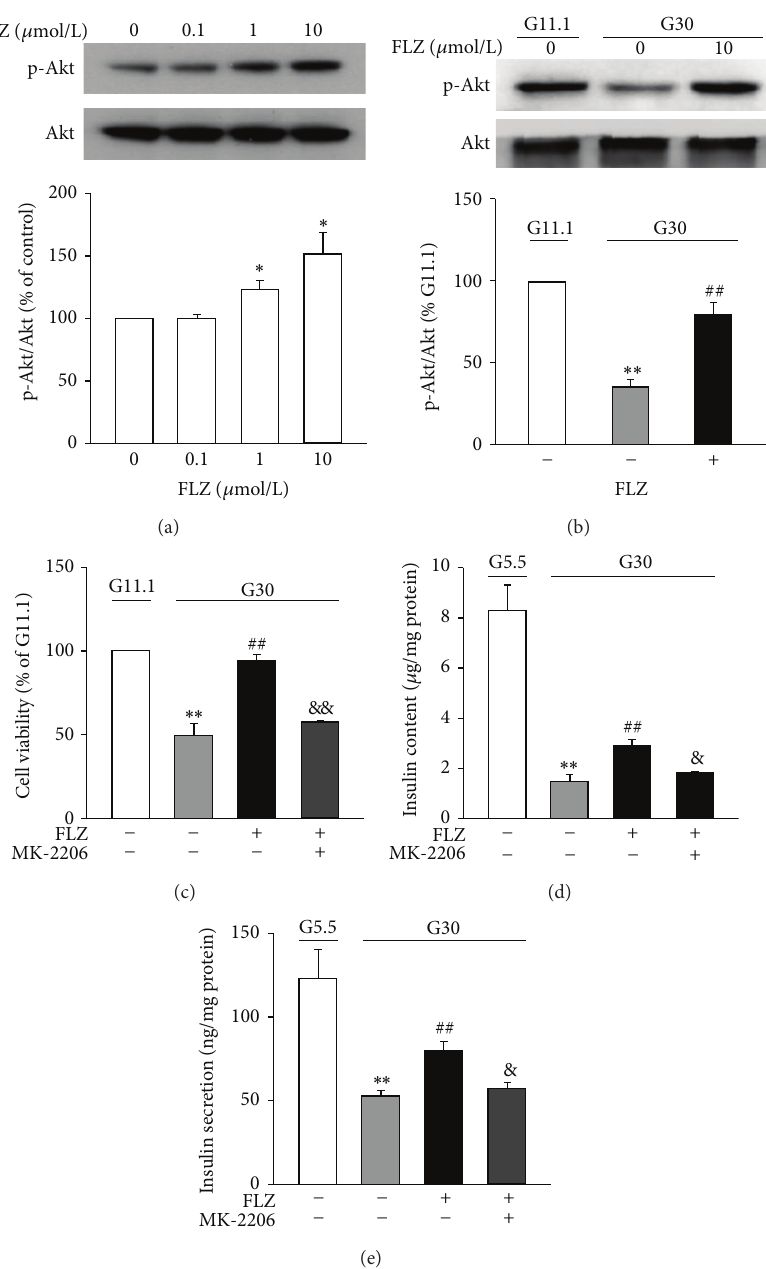
Figure 4: FLZ acts via stimulation of Akt. (a) INS-1E cells were treated with 0.1 𝜇 M, 1 𝜇 M, and 10 𝜇 M FLZ for 8 h. Expression of p-Akt and total Akt protein was determined by western blot. Mean ± S.E.M. of three separate experiments. Intensities of p-Akt protein expression were quantified, normalized against the level of total Akt, and expressed as fold of protein abundance in INS-1E cells treated with DMSO. ∗ 𝑝 < 0.05 versus control. (b) INS-1E cells were cultured at G11.1 or G30 for 4 days. Cells were treated without or with 10 𝜇 M FLZ. Expression of p-Akt and total Akt protein was determined by western blot. Mean ± S.E.M. of seven separate experiments. ∗∗ 𝑝 < 0.01 versus the value at G11.1; ## 𝑝 < 0.01 versus the value at G30 without FLZ. (c) Cell viability was assessed in INS-1E cells being cultured at G11.1 and G30 for 4 days. Cells were treated without or with 10 𝜇 M FLZ or simultaneous addition of 10 𝜇 M FLZ and 50 nM MK-2206. Values were expressed as percentage of cell viability at G11.1. Data are means ± S.E.M. of 3-4 independent experiments. ∗∗ 𝑝 < 0.01 versus the value at G5.5; ## 𝑝 < 0.01 versus the value at G30 without FLZ; && 𝑝 < 0.01 versus the value at G30 with FLZ. (d) Insulin content was assayed without or with 10 𝜇 M FLZ or simultaneous addition of 10 𝜇 M FLZ and 50 nM MK-2206. Values are normalized against total protein. Data are means ± S.E.M. of 4–12 experiments. ∗∗ 𝑝 < 0.01 versus the value at G5.5; ## 𝑝 < 0.01 versus the value at G30 without FLZ; & 𝑝 < 0.05 versus the value at G30 with FLZ. (e) Insulin secretion was assayed in INS-1E cells treated without or with 10 𝜇 M FLZ or simultaneous addition of 10 𝜇 M FLZ and 50nM MK-2206. Values were normalized against total protein. Data are mean ± S.E.M. of 5–16 separate experiments. ∗∗ 𝑝 < 0.01 versus the value at G5.5; ## 𝑝 < 0.01 versus the value at G30 without FLZ; & 𝑝 < 0.05 versus the value at G30 with